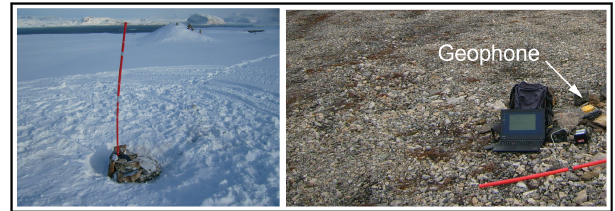
Figure A1. Photos of a station of the KBSA array after deploy- ment in April and a station of the BRA array during data retrieval in August (geophone uncovered).